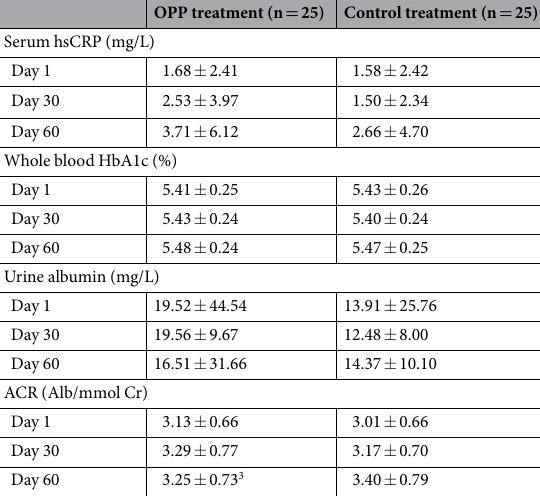
Table 10. Special chemistry profile (mean ± SD).